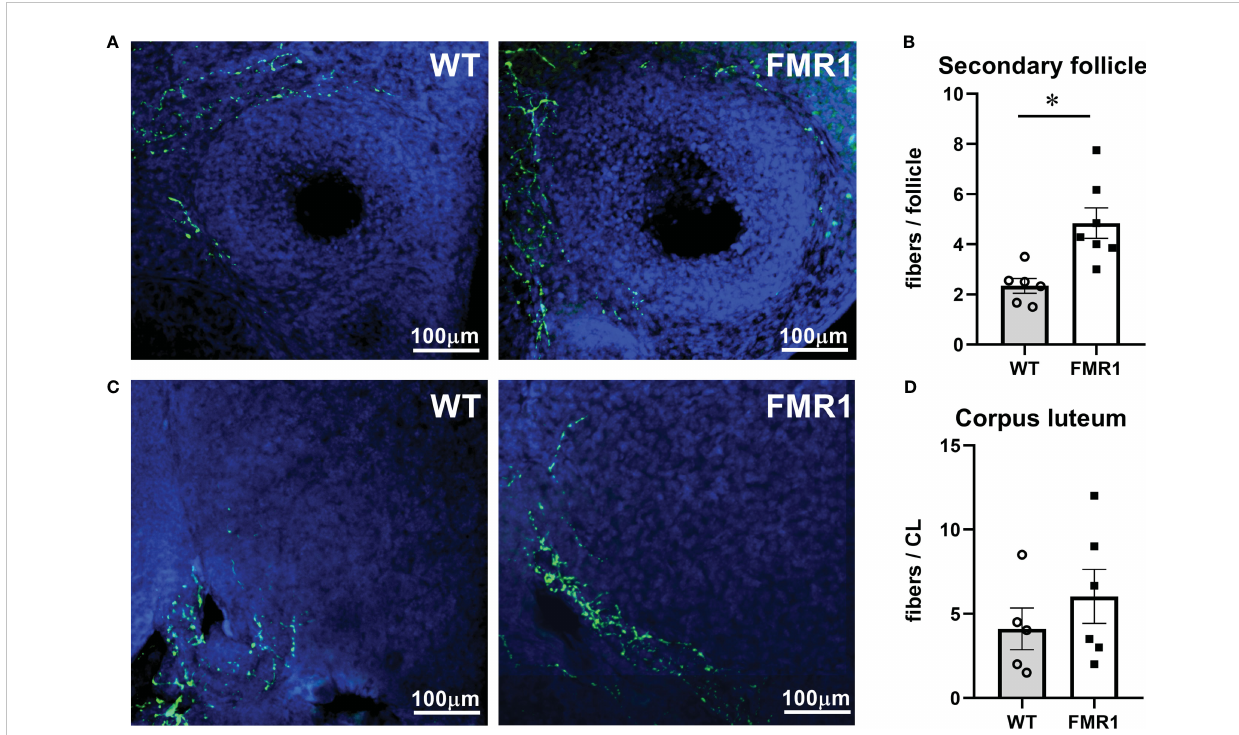
FIGURE 6 Fmr1 KO have higher innervation of growing follicles. Ovaries were sectioned and stained with antibodies to tyrosine hydroxylase (TH, green) to visualize innervation around secondary follicles (A) and corpora lutea (C) . Fibers that surround the follicles and penetrate theca layer were counted (B, D) . * indicates signi fi cant